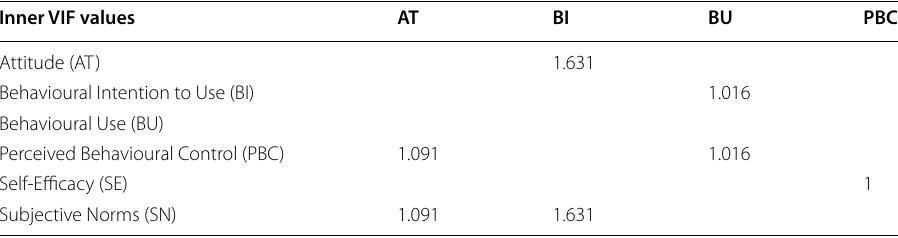
Table 6 Multicollinearity test Inner VIF